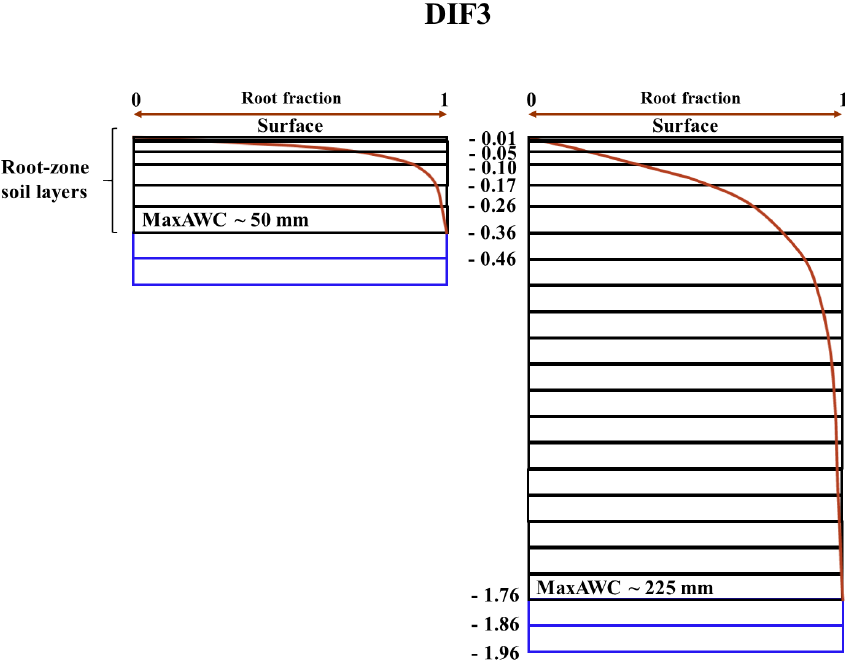
Figure 6. As in Fig. 4, except for the DIF3 experiment. Two subroot soil layers of 10cm are added (blue